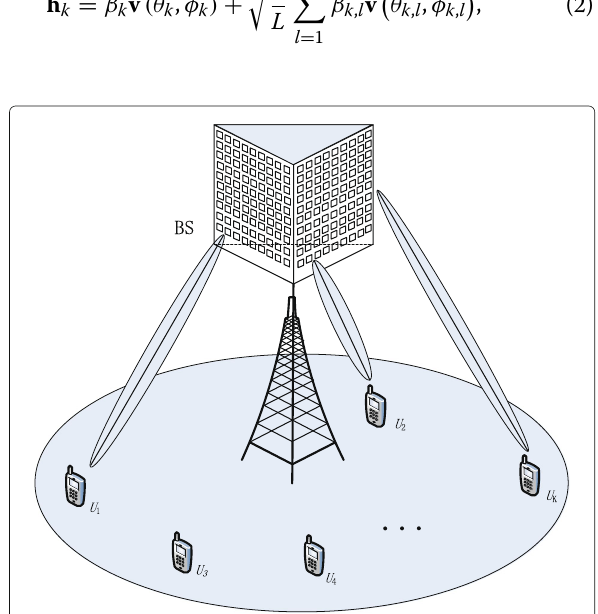
Fig. 1 A schematic diagram of the multi-user MIMO mmWave system, where a BS equipped with a URA serves K